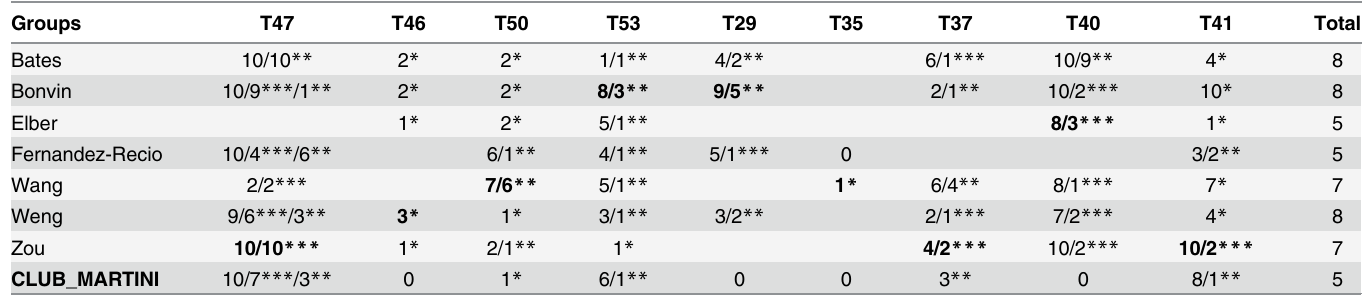
The Table lists the number of acceptable or better quality models from different groups. For each group, the number of submitted correct models of each category are listed: high( *** ), medium( ** ), and acceptable ( * ) are listed. For example, ‘ 10/7 *** /3 ** ’ means that there are 10 acceptable or better quality binding poses in total, of which 7 structures are with high quality and 3 models are with medium accuracy. Note that all number in the table except our method are from previous CAPRI paper